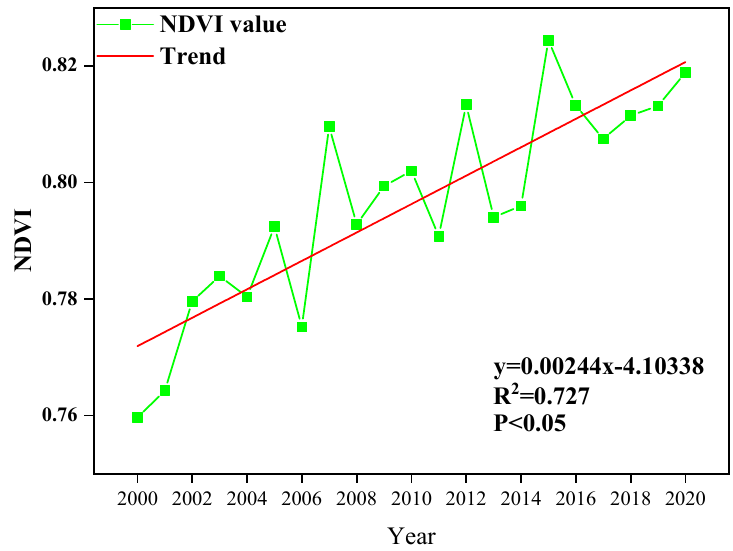
Figure 3. Changes in annual vegetation cover in Chongqing.